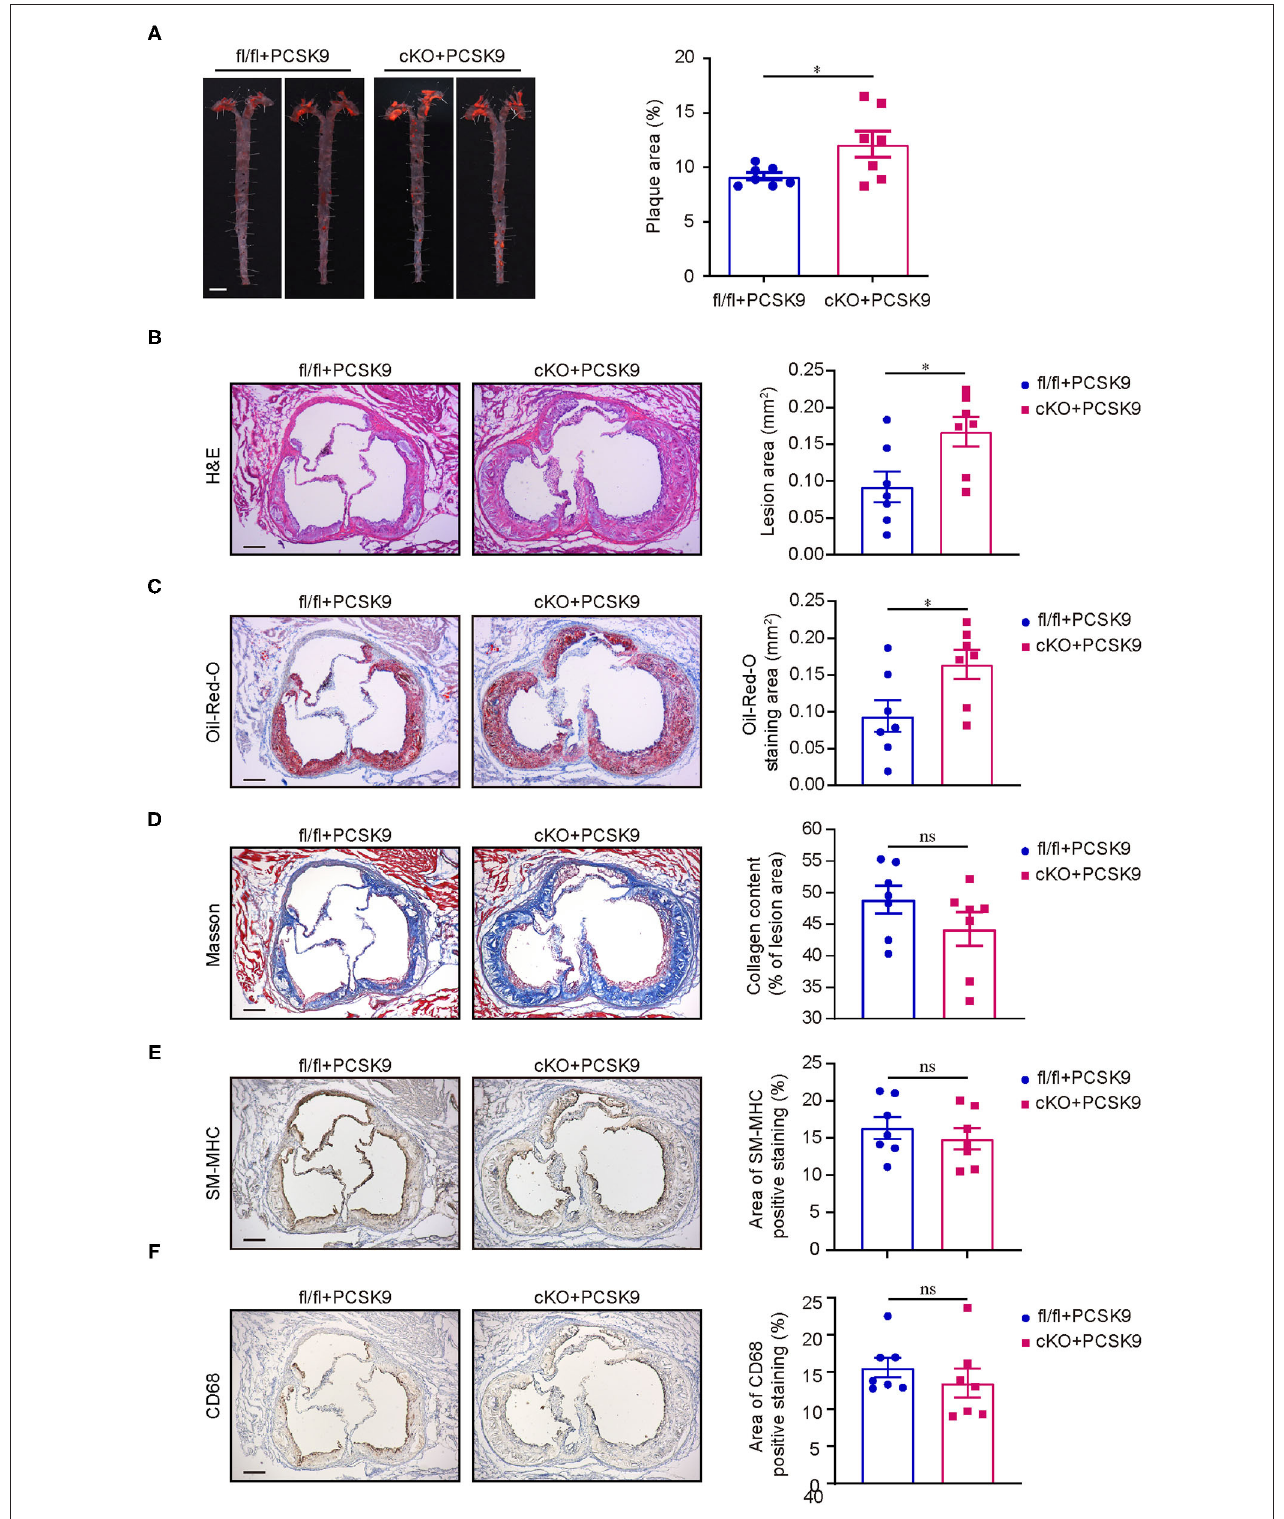
FIGURE 3 | PP2A deficiency in myeloid cells aggravated atherosclerosis in mice. (A) Left panel: representative images of Oil-Red-O staining of whole aortas from Ppp2c α flox / flox and Lyz2-Cre/Ppp2c α flox / flox mice injected with AAV-PCSK9 after 16 weeks of high-fat and high-cholesterol diet feeding. Bar = 2.5mm. Right panel: quantification of aortic atherosclerotic plaque area ( n = 7). (B) Left panel: representative image of aortic root cross sections stained with H & E. Bar = 100 µ m. Right